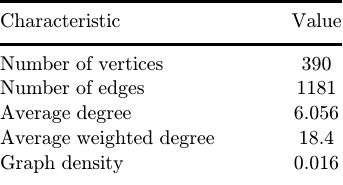
Table 2. Characteristics and statistics of the obtained graph.